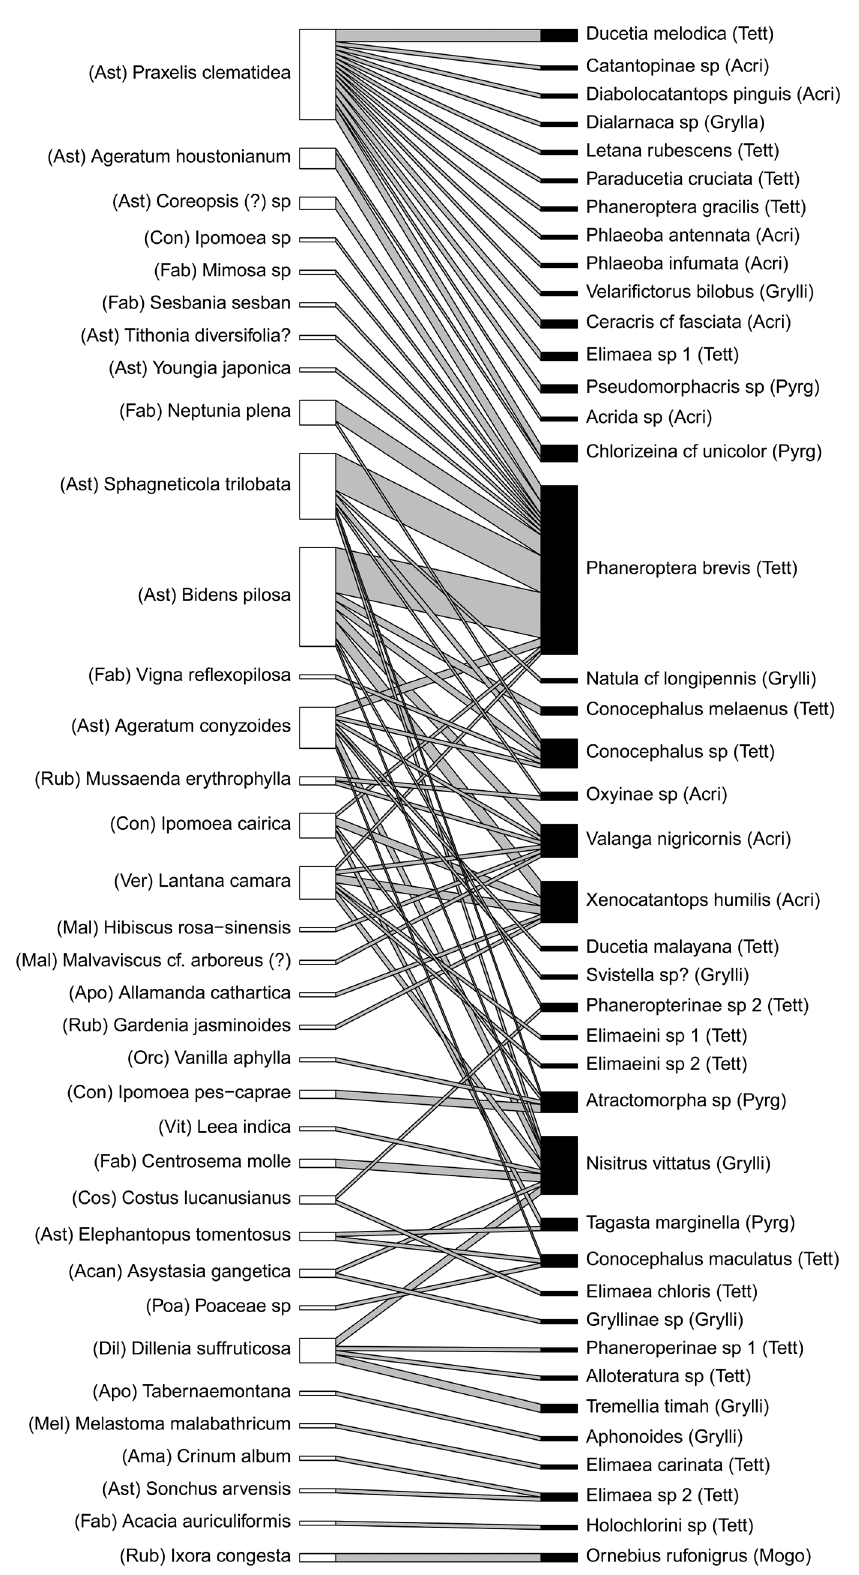
Fig. 2. The interaction web between flower-visiting orthopterans (right row) and flower species (left row) in Southeast Asia. The width of the linkage represents the number of observations. Legends for orthopteran families: Acri = Acrididae; Grylla = Gryllacrididae; Grylli = Gryllidae; Mogo = Mogoplistidae; Pyrg =Pyrgomorphidae; Tett = Tettigoniidae. Legends for flower families: Aca = Acanthaceae; Ama = Amaryllidaceae; Apo = Apocynaceae; Ast = Asteraceae; Con = Convolvulaceae; Cos = Costaceae; Dil = Dilleniaceae; Fab = Fabaceae; Mal = Malvaceae; Mel = Melastomataceae; Orc = Orchidaceae; Poa = Poaceae; Rub = Rubiaceae; Ver = Verbenaceae; Vit =